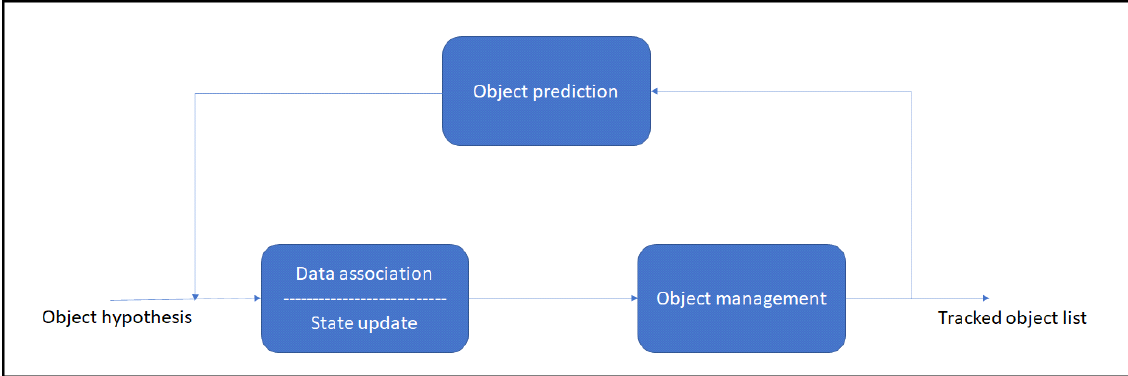
Figure 5. Architecture of multi-object tracking.